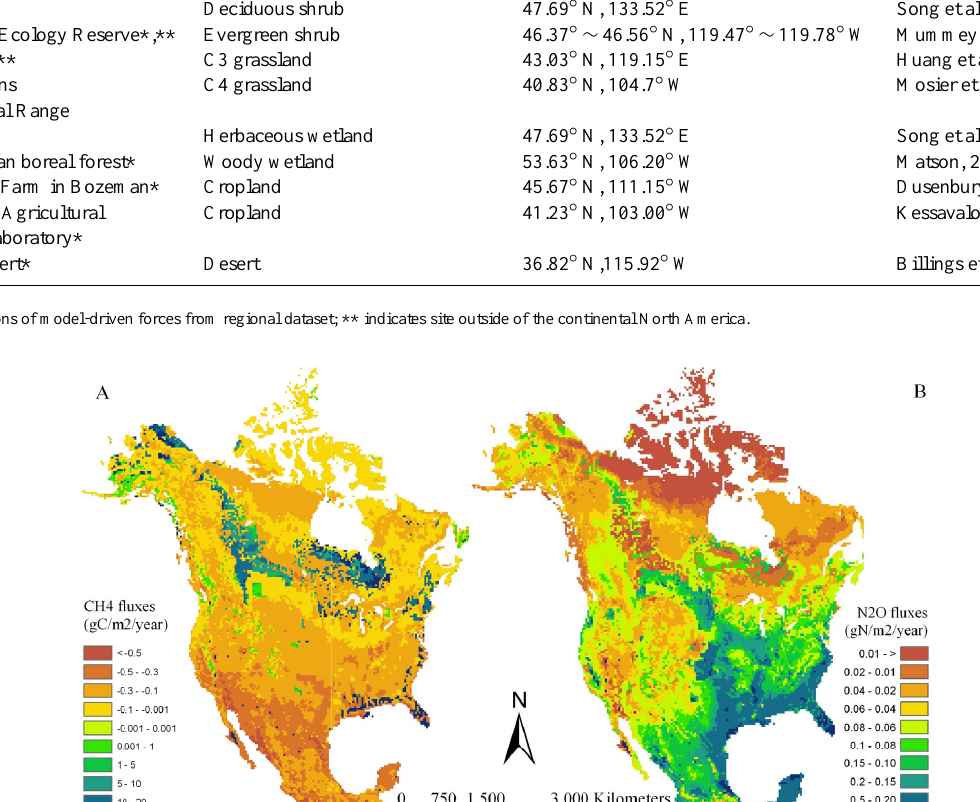
Fig. 7. Spatial distribution of (A) CH 4 and (B) N 2 O fluxes in North America’s terrestrial ecosystems during